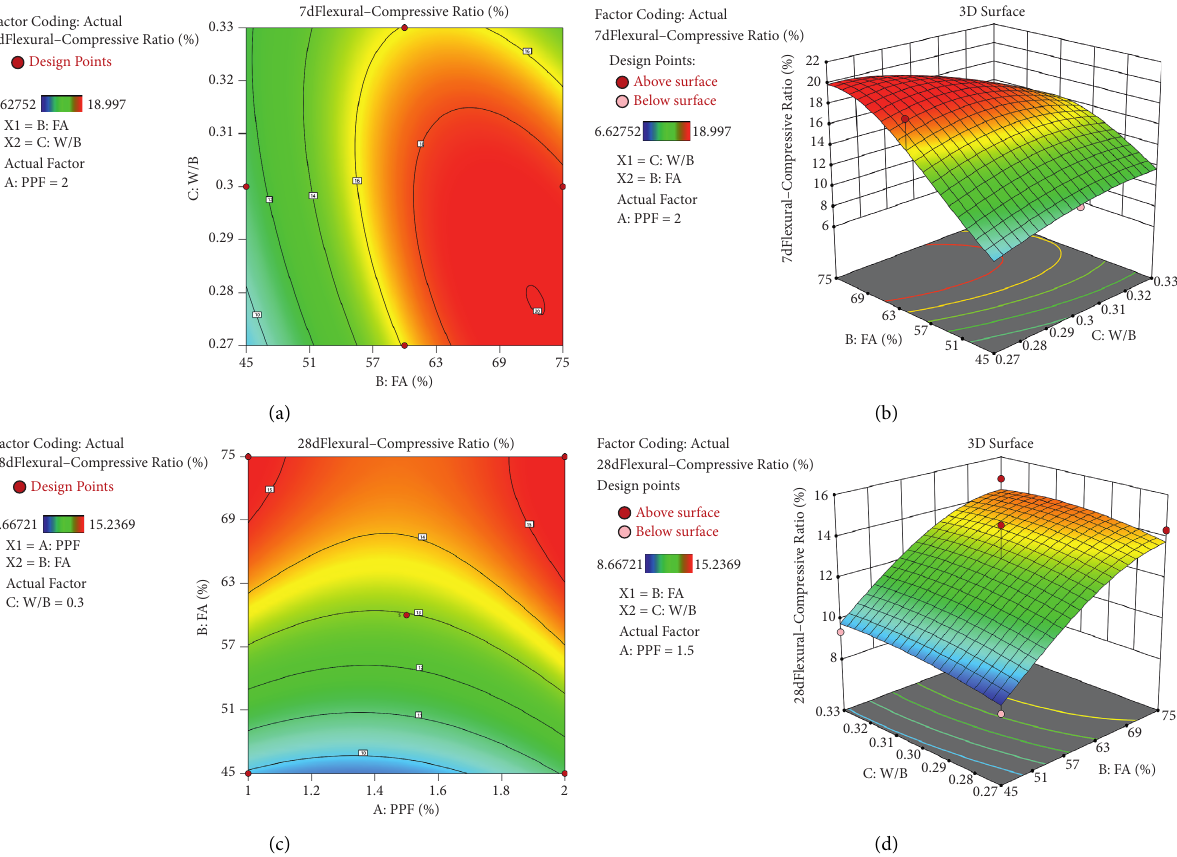
Figure 14: Contour plots. (a, b) 7 d flexural-compressive ratio. (c, d) 28 d flexural-compressive ratio.